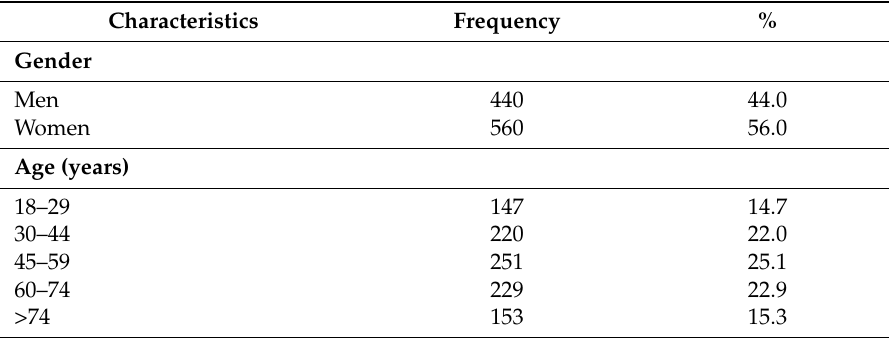
Table 1. Descriptive statistics of socio-demographic characteristics of the study